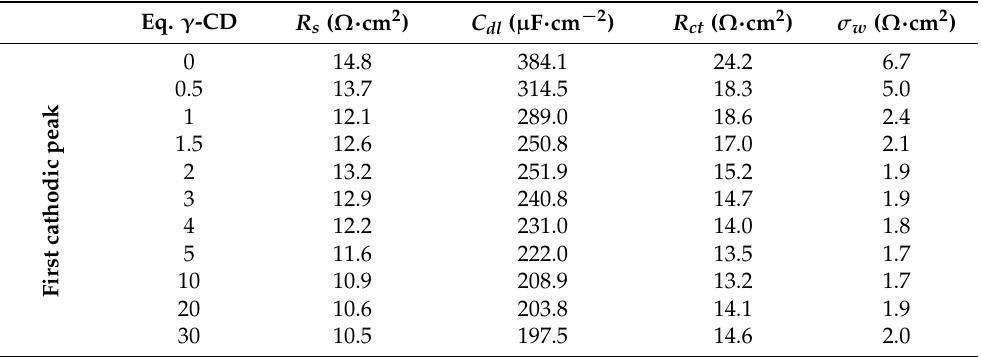
Table 1. Electrochemical parameters obtained from the best fit of impedance data for POM